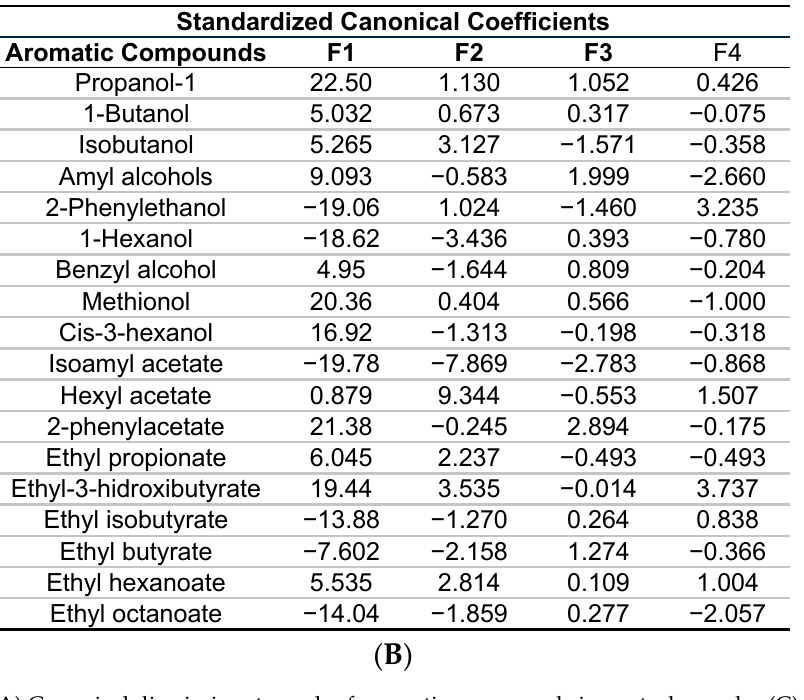
Figure 6. ( A ) Canonical discriminant graph of aromatic compounds in control samples (C), samples